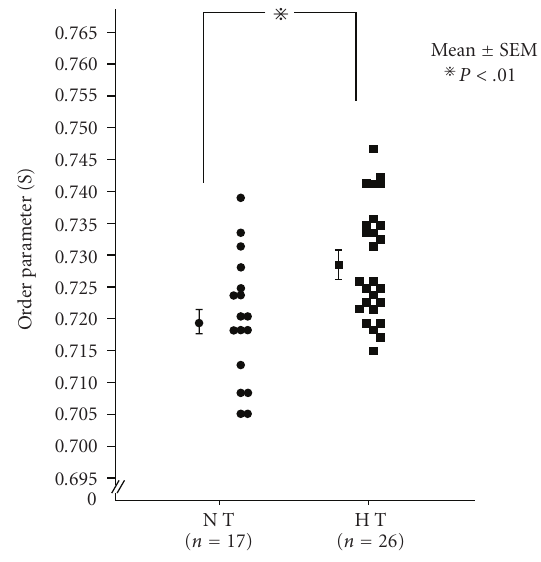
Figure 2: Membrane fluidity of red blood cells (RBCs) in hyper- tensive and normotensive men. The greater the value of the order parameter ( S ) was, the lower the membrane fluidity of RBCs